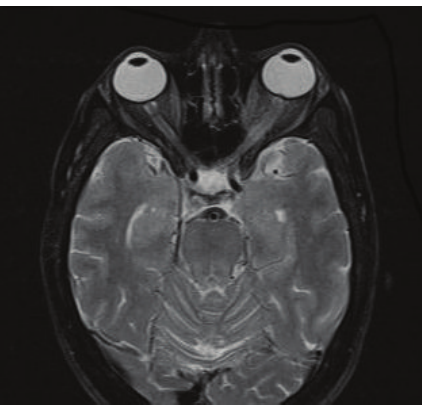
Figure 1: Cranial magnetic resonance imaging of neuropathy in the left optic